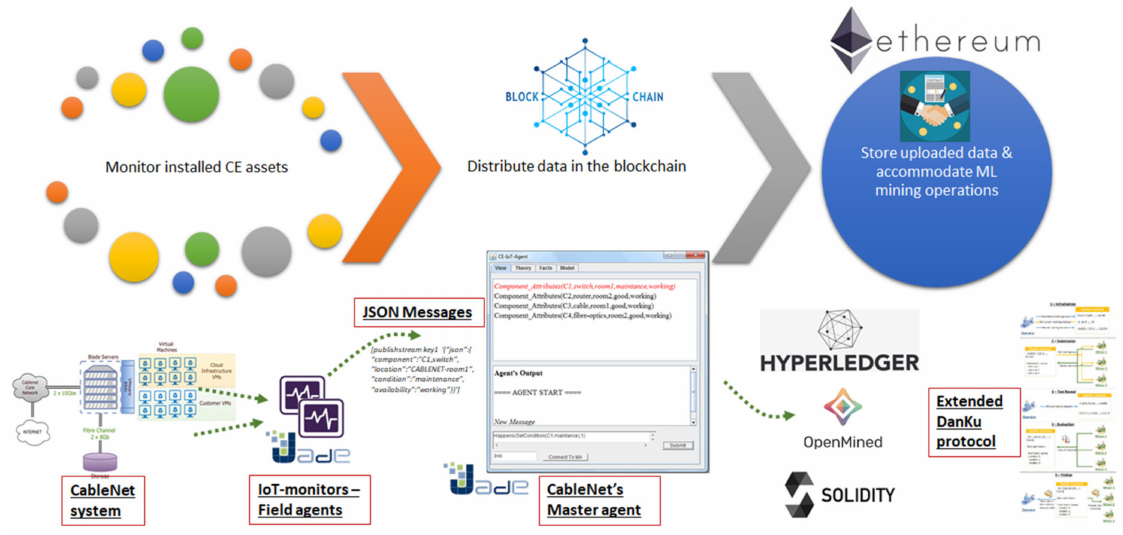
Figure 4. The CE-IoT